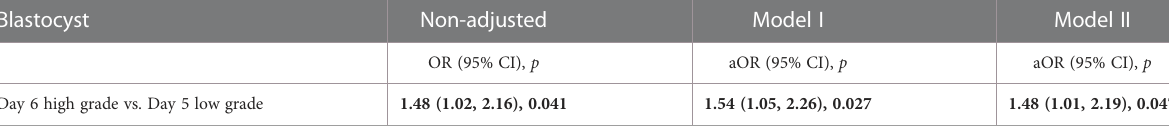
TABLE 3 Adjusted odds ratio of live birth rate in a multivariate logistic regression analysis. Blastocyst